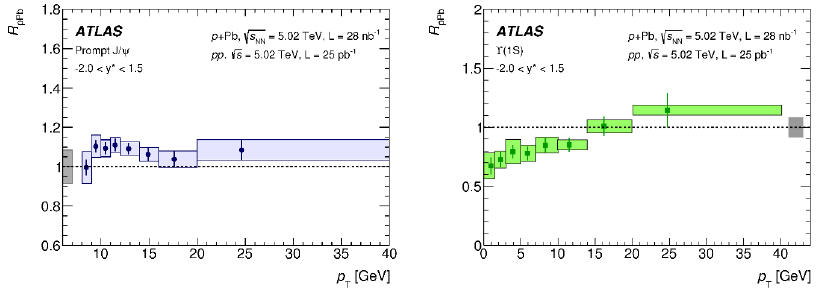
Figure 3: The nuclear modification factor, RpPb, as a function of transverse momentum pT for prompt J /ψ (left) and Υ (1 S